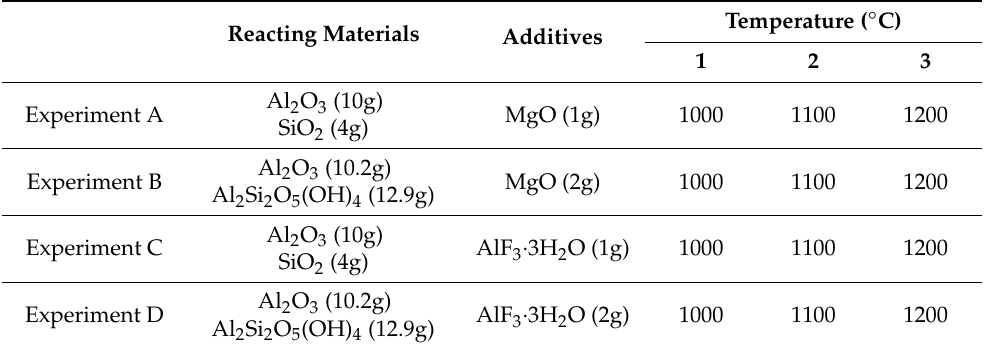
Table 1. Stoichiometric data of the reactants in experiments A, B, C, and D. Reacting Materials